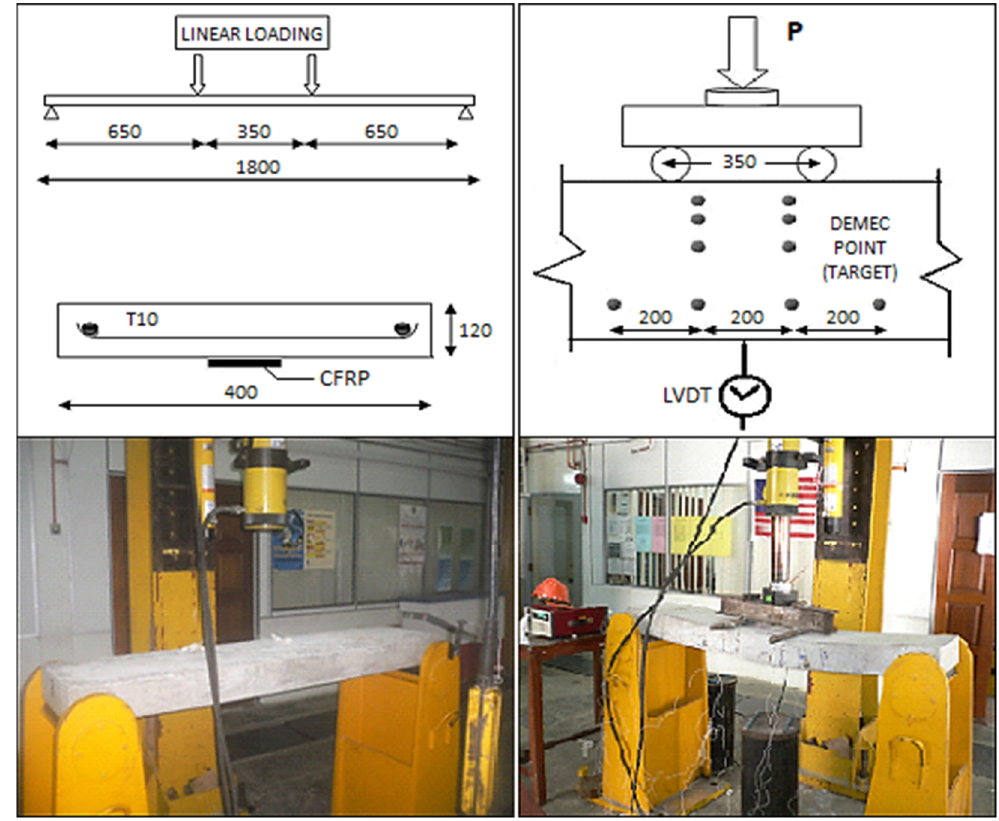
Table 7. Tested slabs and properties of CFRP laminates.